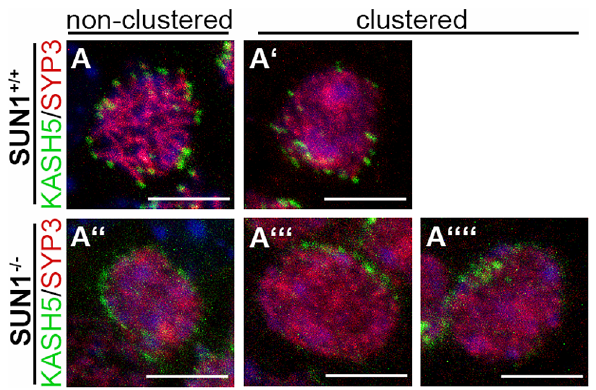
Figure 4. Meiotic telomere clustering in the absence of SUN1. Representative projections of entire spermatocyte nuclei of Sun1 + / + ( D ex10-11) and Sun1 2 / 2 ( D ex10-11) mice labeled by KASH5 and SYCP3. As expected non-clustered (A) and clustered (A 9 ) telomere patterns are observed in wildtype spermatocytes. Similar non-clustered (A 0 ) as well as clustered (A 90 –A 00 ) telomere patterns could also be found in SUN1 deficient spermatocytes. All scale bars 5 m